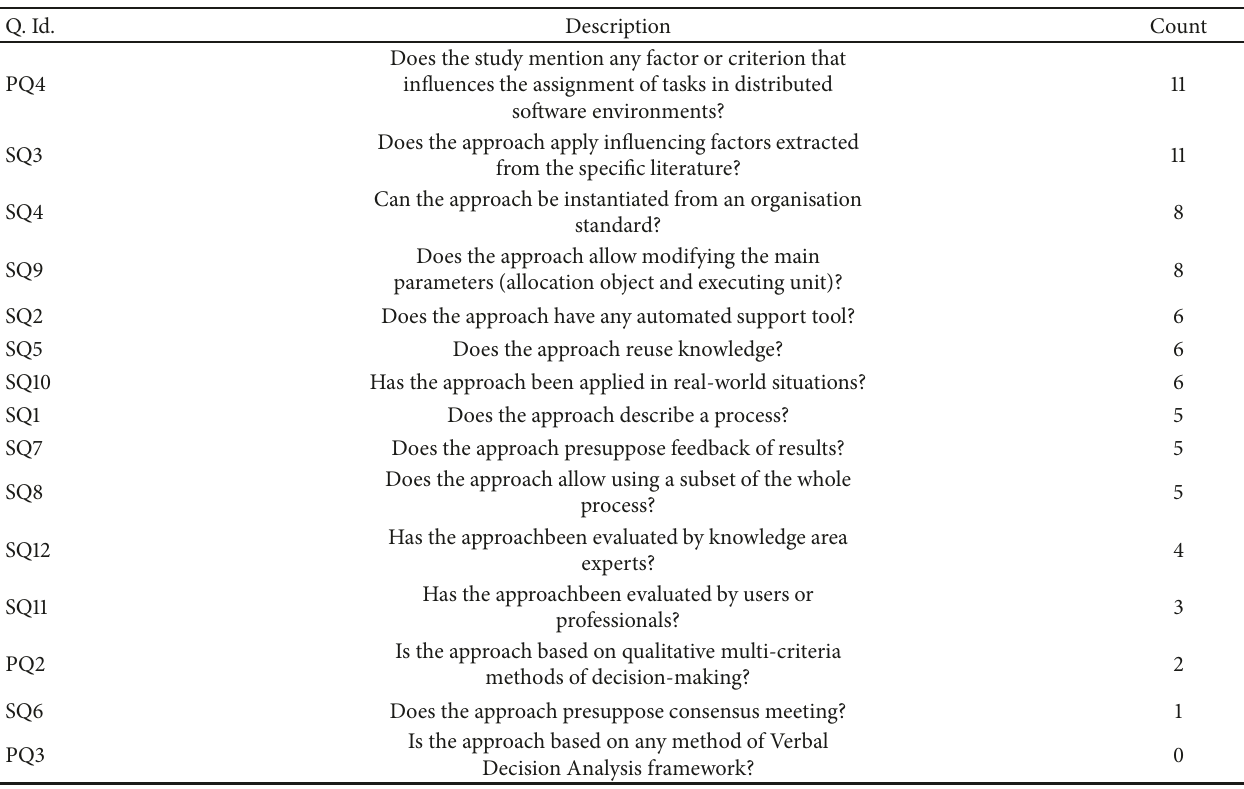
Figure 1: The process of the DiVA approach. Table 3: Total approaches that scored for each